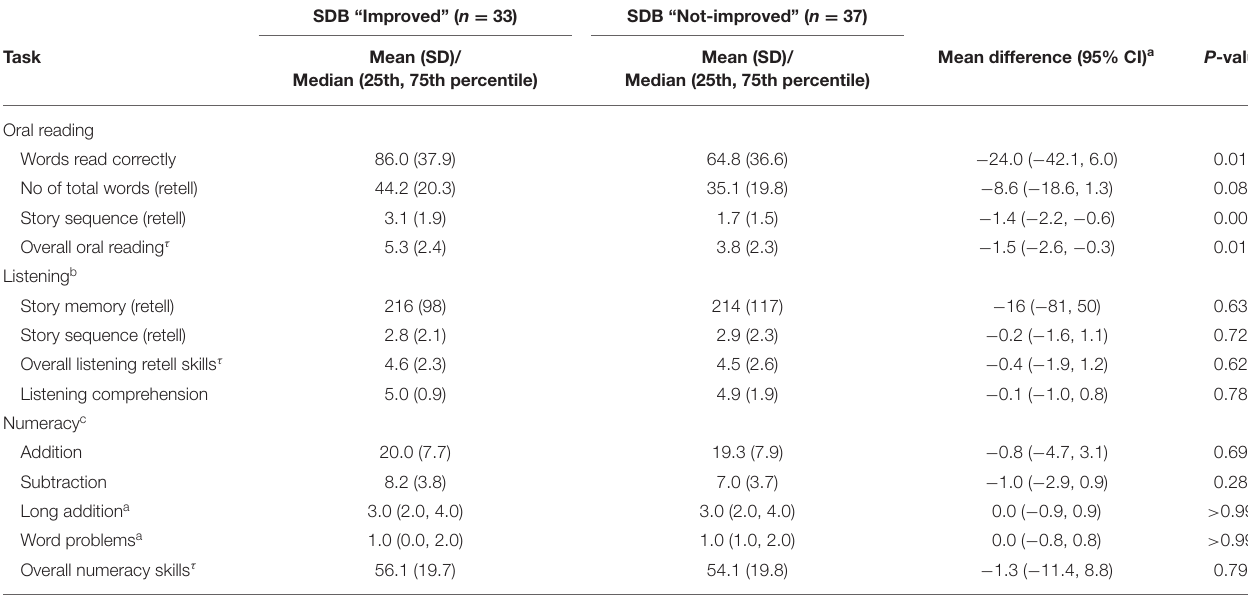
TABLE 4 | Difference in academic performance scores at age 8 by SDB trajectory group.